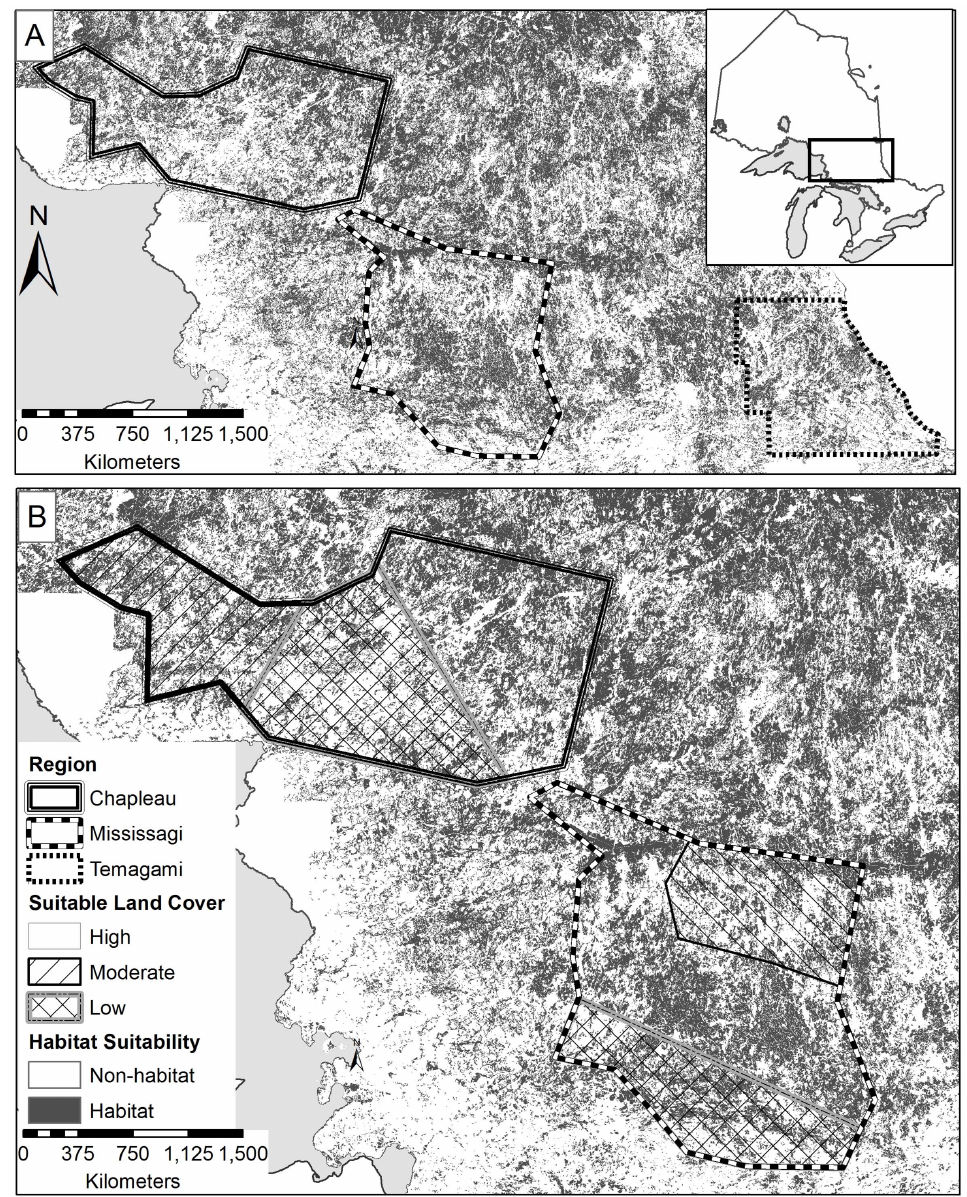
Figure 1. Habitat suitability map for Canada lynx in (A) central Ontario with Regions outlined and (B) suitable land cover levels within each region, as determined by the literature-based habitat suitability model.